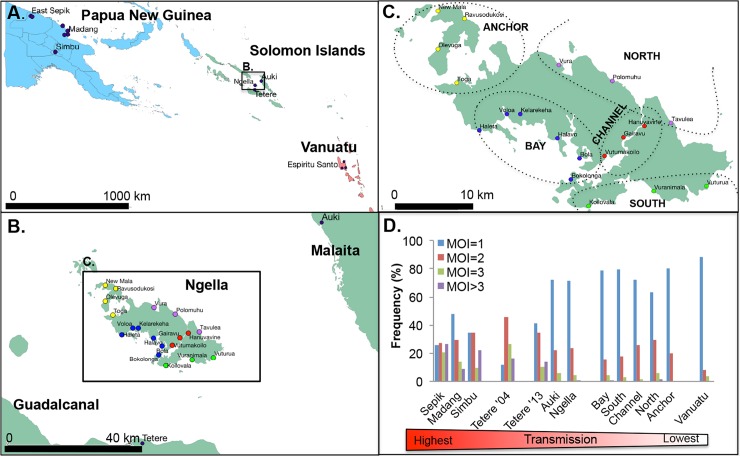
Map of the study areas and transmission intensity.(A) Southwest Pacific sampling locations showing Papua New Guinea in blue, Solomon Islands in green and Vanuatu in red, (B) central Solomon Islands, (C) Ngella, showing 19 villages and five distinct geographical/ecological regions. Anchor villages are indicated in yellow, Bay in blue, South Coast in green, Channel in red and North Coast in purple). Maps were produced using an open source map with shape files downloaded from diva-gis.org using the open source software QGIS release 2.18. (D) The distribution of multiplicity of infection values in each defined population, shown as an indicator of P. vivax transmission intensity.